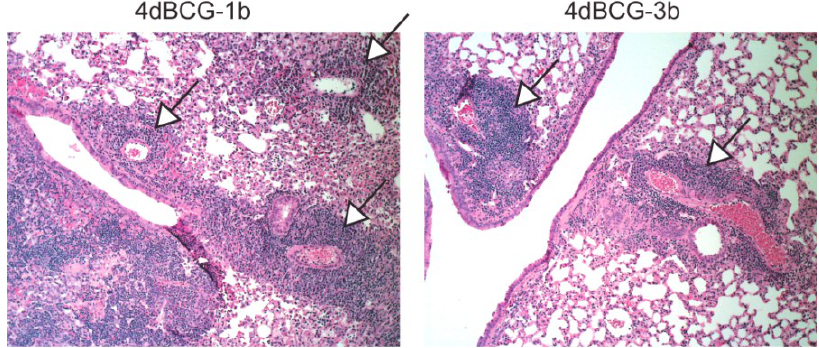
Figure 7. Bronchus-associated lymphoid tissue (BALT). The panels display ×10 enlargements of the lung sections from mice vaccinated with 4dBCG as represented by the white rectangles in Figure 4. BALT was prominent along the central bronchovascular structures in all three groups of mice (see Figure 5) and its association with blood vessels and bronchi distinguishes BALT from collections of lymphocytes in the lung